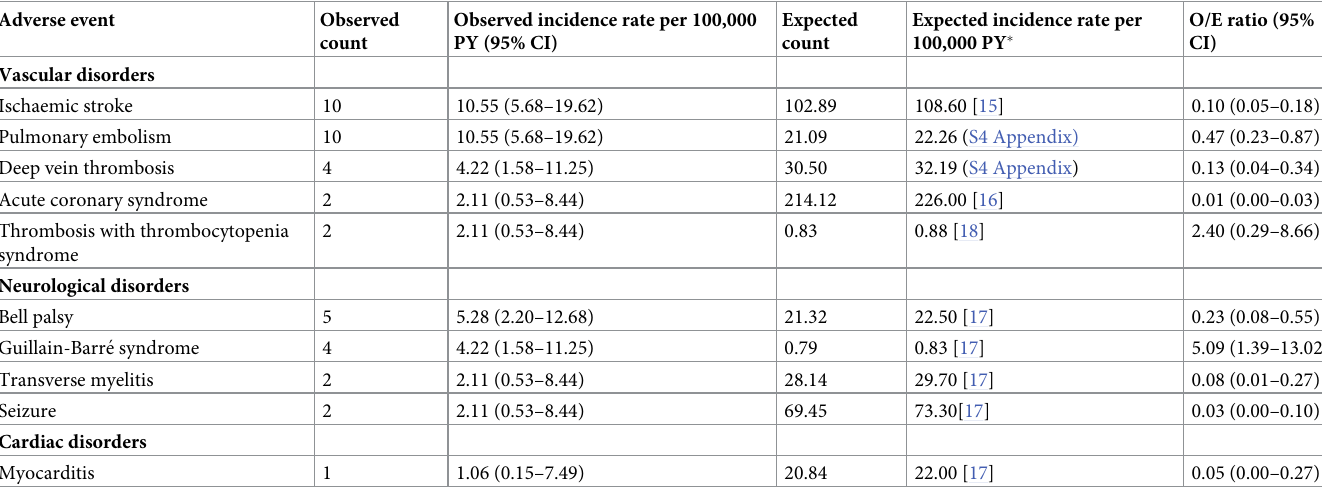
nation, but there was not a significant change in the observed versus expected ratios of SAEs. Table 3. Observed versus expected (O/E) analysis of selected serious adverse